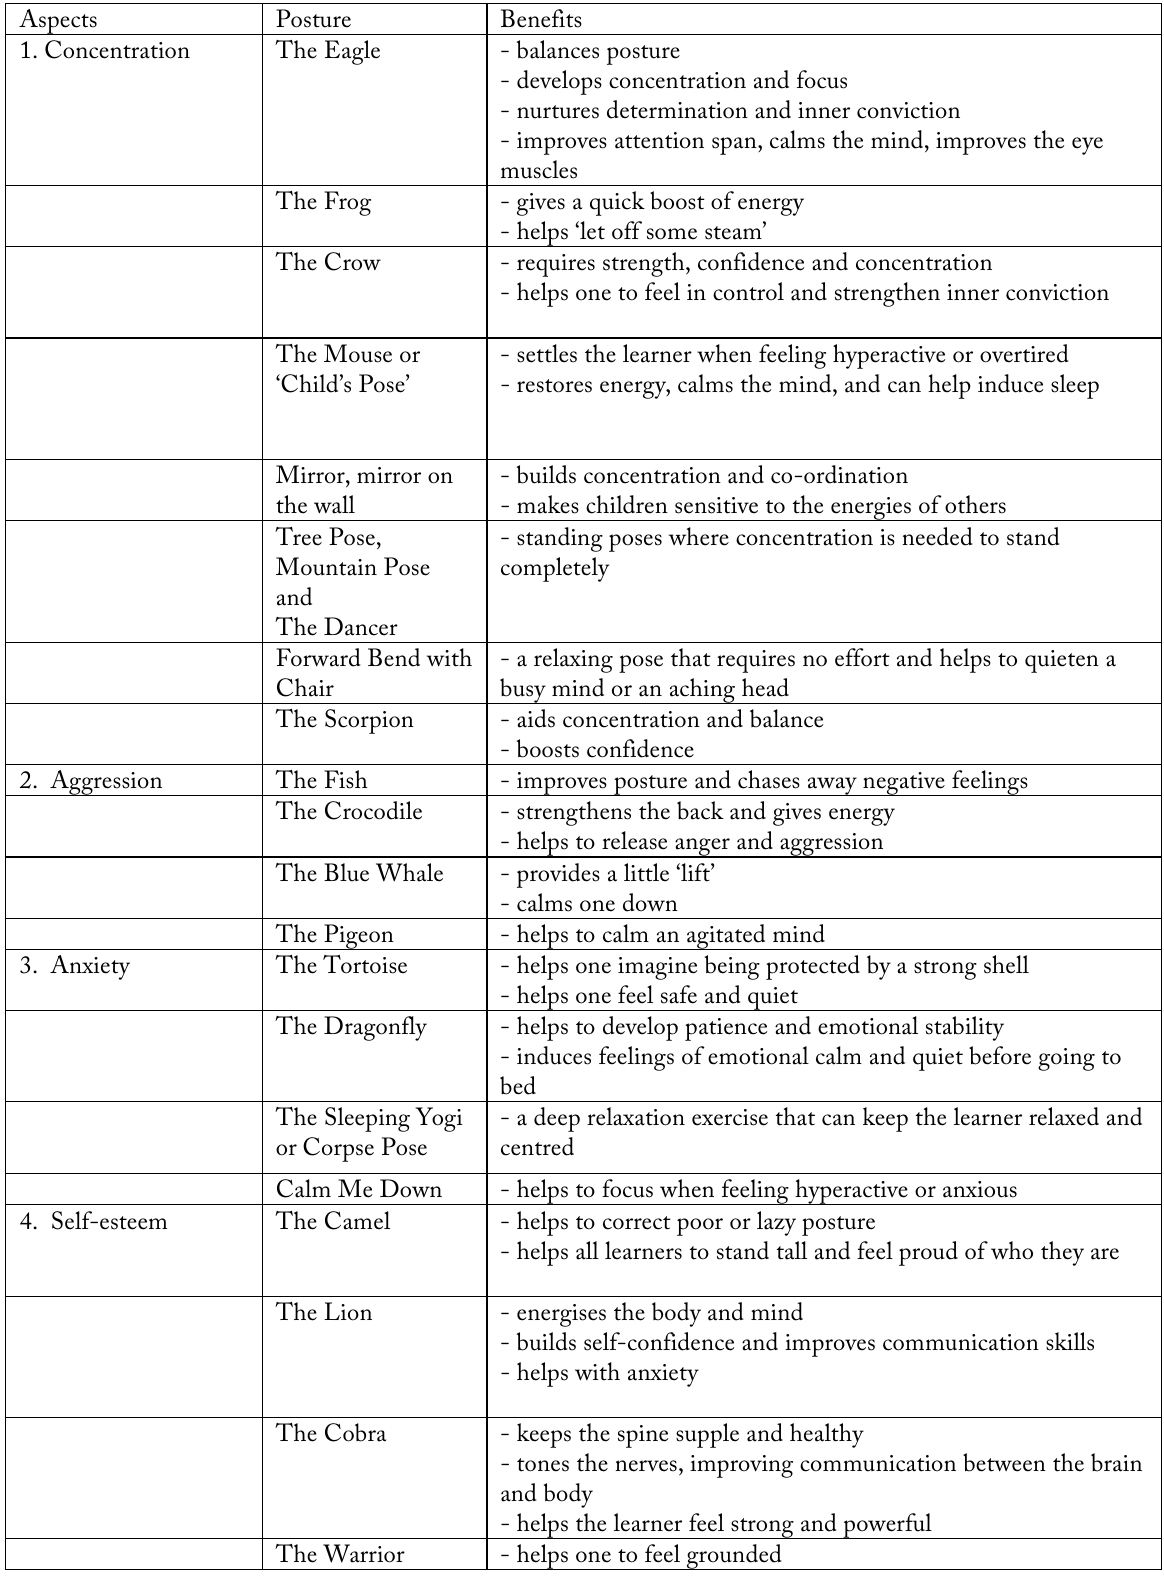
Table 1. Yoga postures used in the intervention Aspects Posture